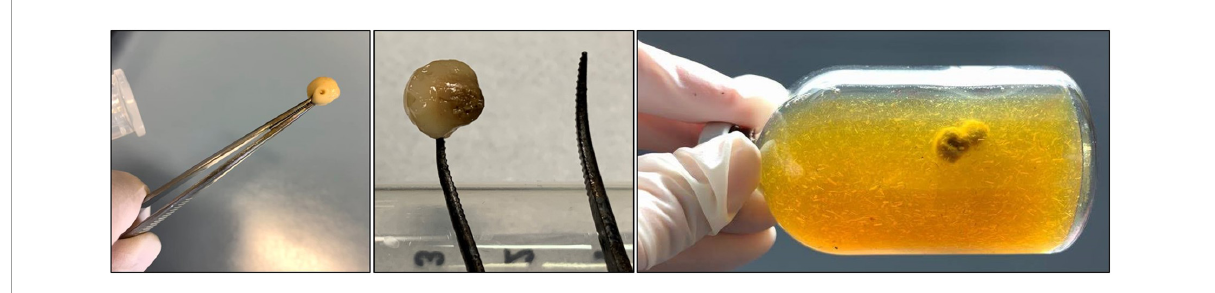
FIGURE10 Biomass ball/sphere of an Anaeromyces mucronatus culture grown in a large serum bottle filled with medium A. The diameter of these balls/spheres can be 0.5–10 mm after seven days of growth.